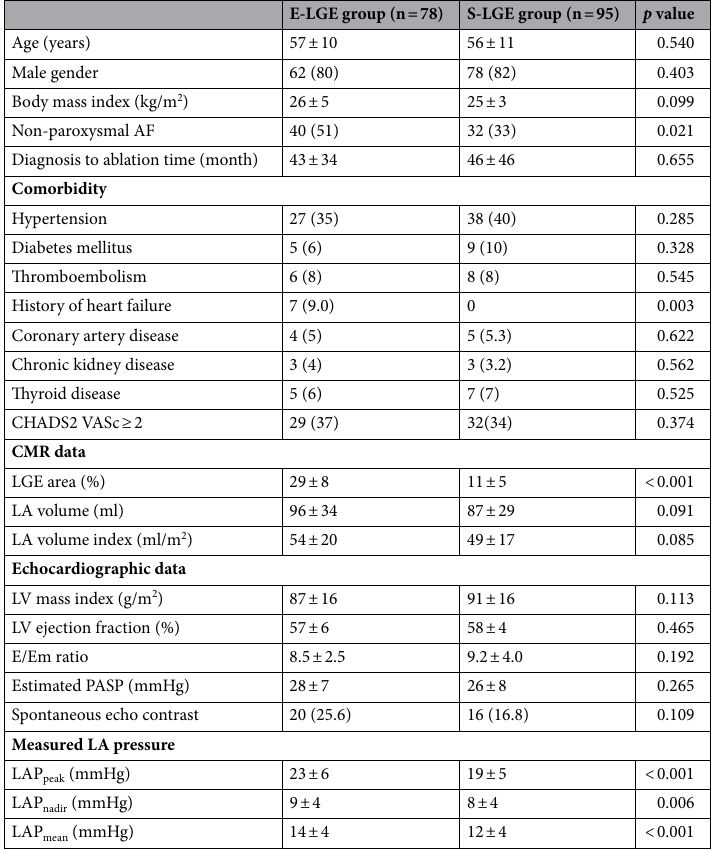
Table 1. Baseline characteristics of study population. Data are presented as n (%) or mean ± standard deviation and analyzed using χ 2 test and unpaired two-tailed t-test or Fisher’s exact test. AF atrial fibrillation, CMR cardiac magnetic resonance, LGE late gadolinium enhancement, LA left atrial, LV left ventricular, PASP pulmonary artery systolic pressure, LAP left atrial